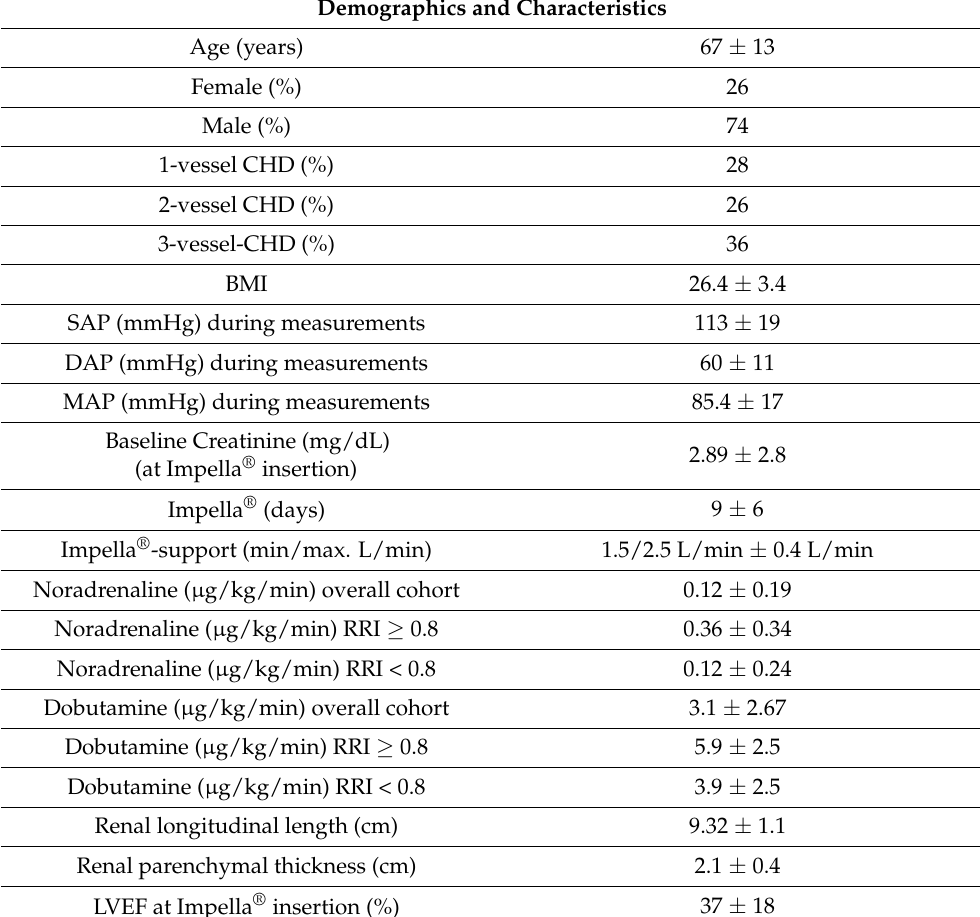
Table 1. Demographics and baseline characteristics. SAP: systolic arterial pressure; DAP: diastolic ar- terial pressure; MAP: median arterial pressure; LVEF: left ventricular ejection fraction; CHD: coronary heart disease; RRI: renal resistive